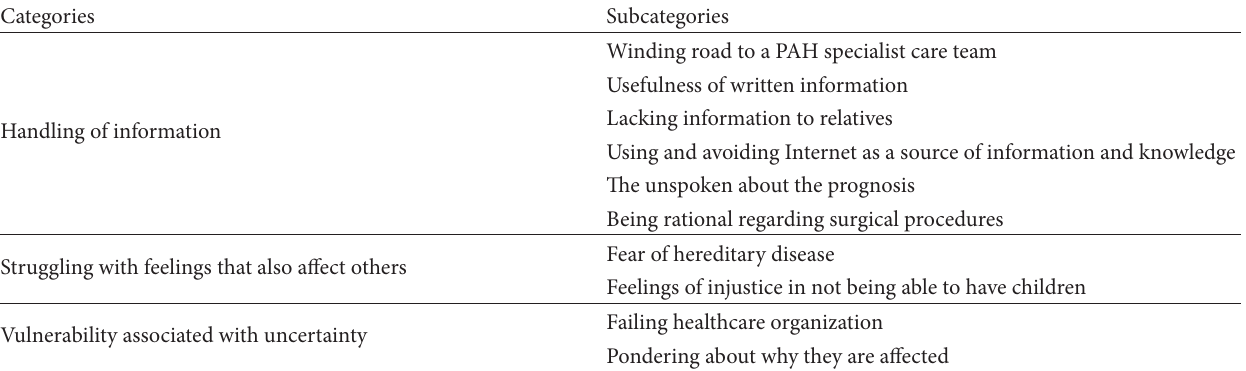
Table 2: A summary of categories and